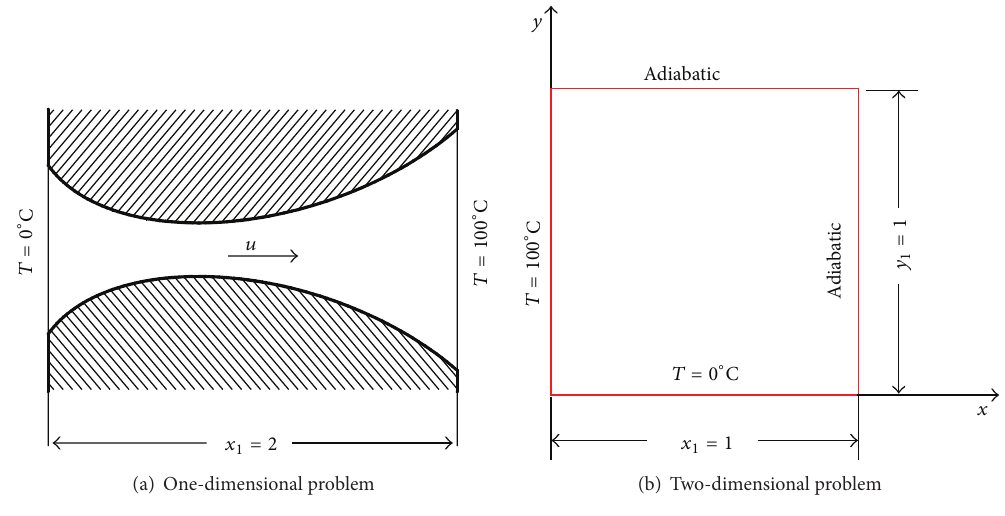
Figure 2: Boundary conditions of two categories of the problem.